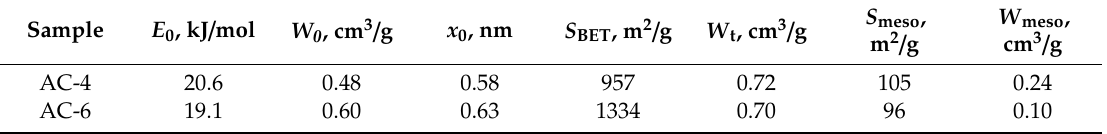
Table 1. The parameters of the porous structure of the peat-derived activated